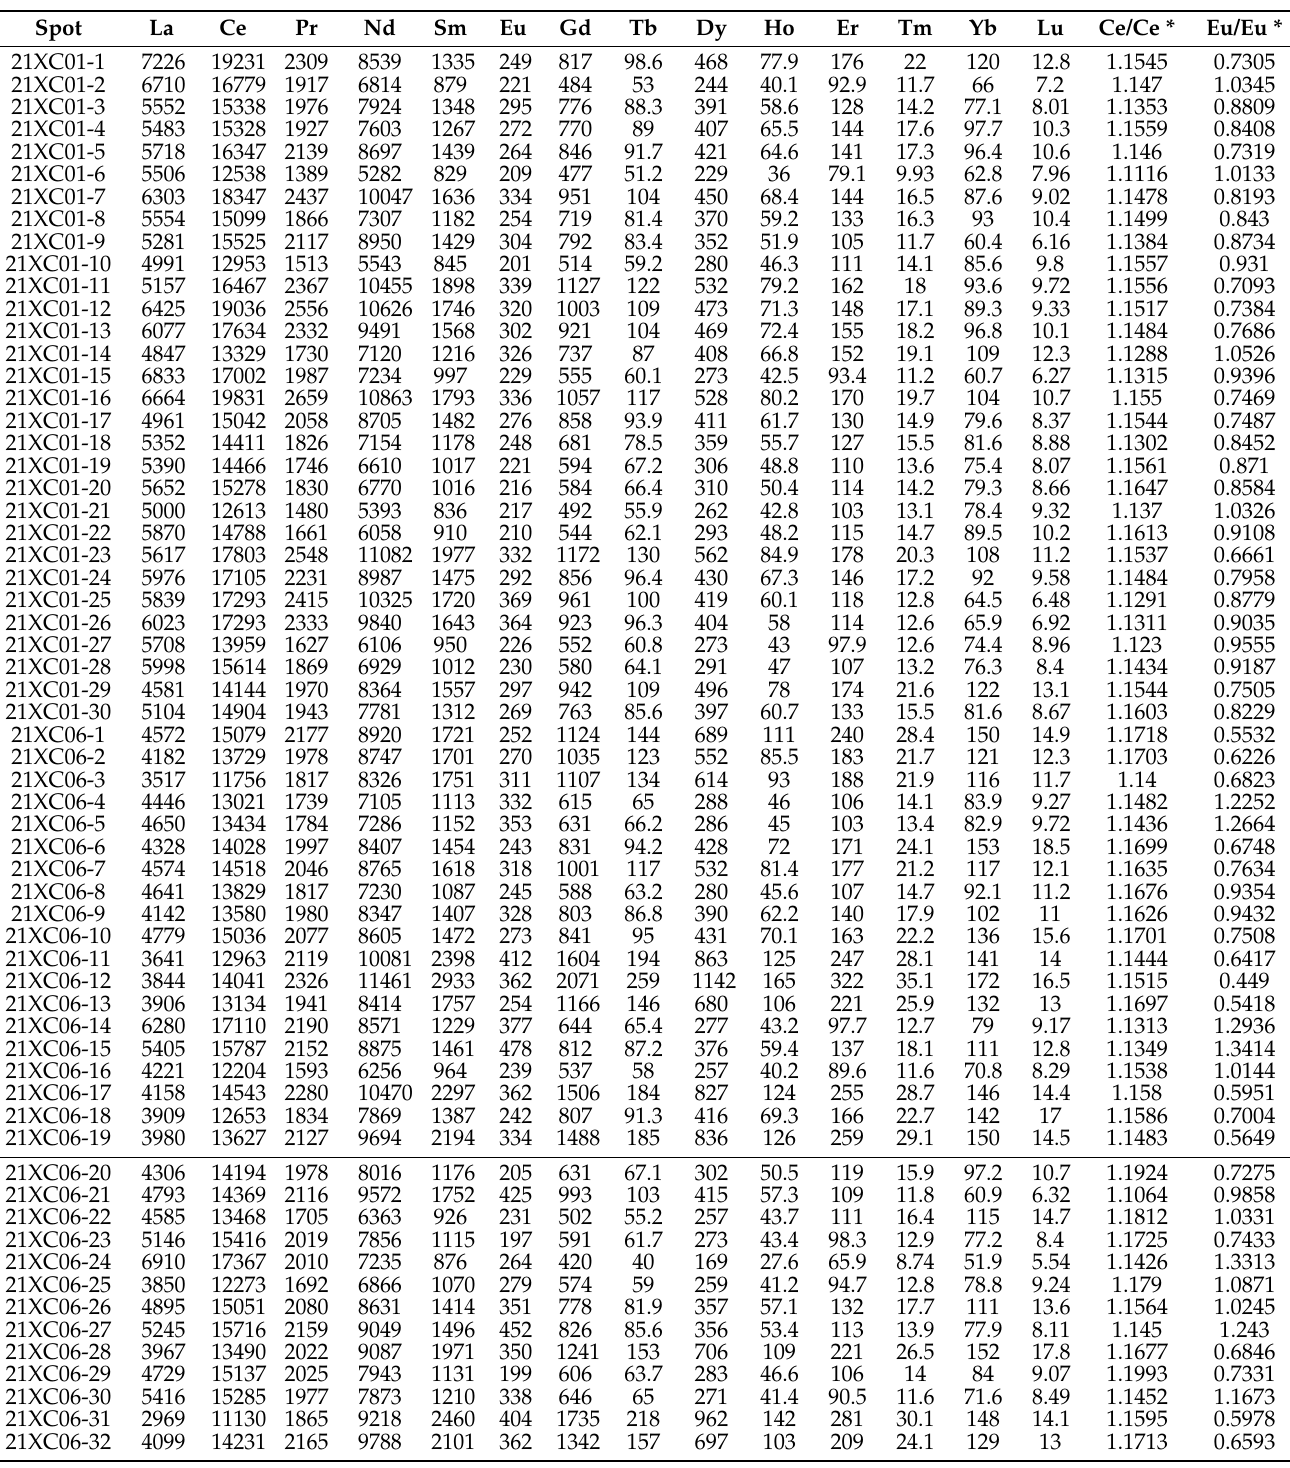
Table 3. Trace-element compositions for the sphene in the alkaline rocks